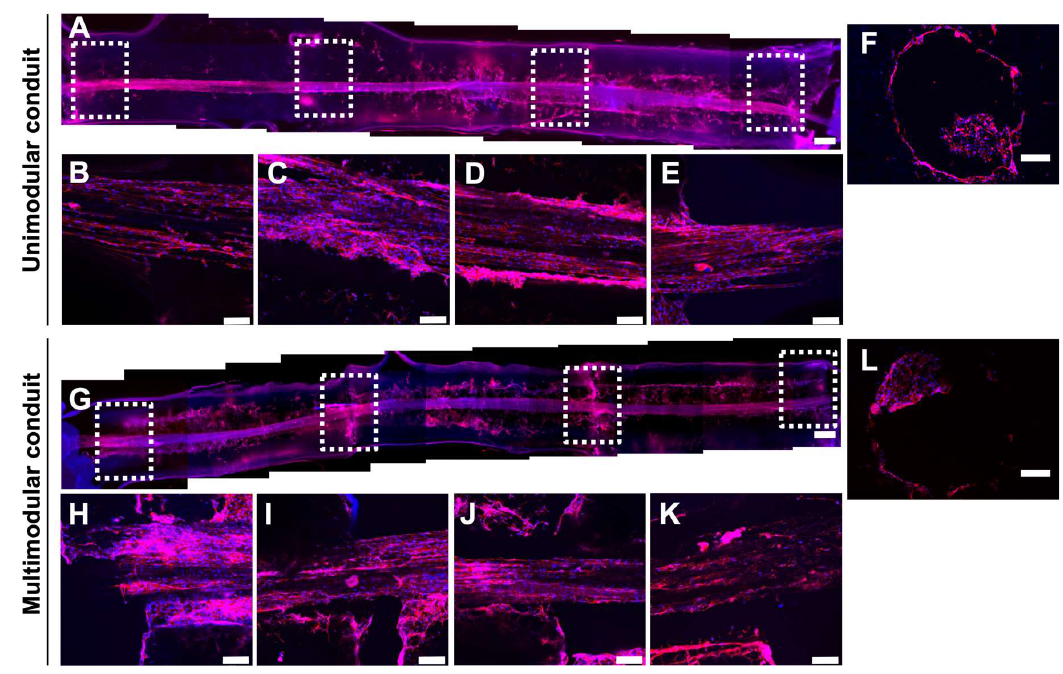
Figure 5. Schwann cells distribution along the whole length and transversal sections of unimodular and multimodular conduits after 5 days. Representative fluorescence reconstruction of the conduit’s complete length of ( A ) unimodular and ( G ) multimodular conduits, after nuclear staining with DAPI (blue) and F-actin of SC staining with ActinRed™ 555 ReadyProbes™ Reagent (red). Confocal fluorescent image of a longitudinal section of unimodular conduit at ( B ) 0 mm, ( C ) 6 mm, ( D ) 12 mm, ( E ) 18 mm, and multimodular conduit at ( H ) 0 mm, ( I ) inter-module zone between modules 1 and 2, ( J ) inter-module zone between modules 2 and 3, ( K ) 18 mm, showing continuity in SC growth even in the absence of the HA conduit. Details in A and G are indicated with white dash lines boxes. Representative fluorescent images of a transversal section at 9 mm long of unimodular conduit ( F ), and multimodular conduit ( L ), after the same staining. Scale bar: 500 µ m ( A , G ), 100 µ m ( B – F , H – L